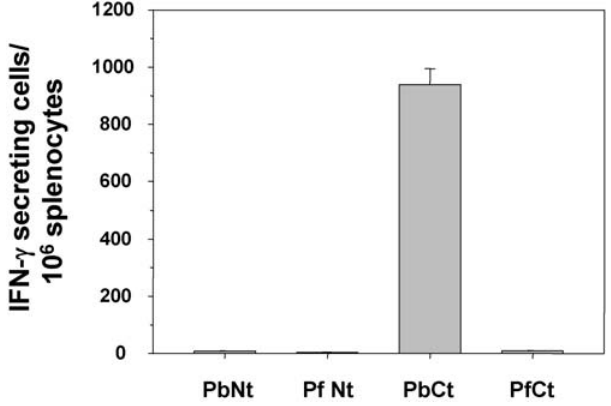
Figure 2. CSP-specific T cells induced by immunization with irradiated P. berghei sporozoites do not cross-react with the P. falciparumCSP expressed by the P.berghei[PfCS]. IFN- c ELISPOT was used to determine the frequency of epitope-specific T cells in the spleens of immunised animals, using long peptides corresponding to the N-terminus (PbNt or PfNt) or the C-terminus (PbCt or PfCt) of P. berghei and P. falciparum , respectively. Results are expressed as the mean 6 SEM of T cells from groups of 5 mice.